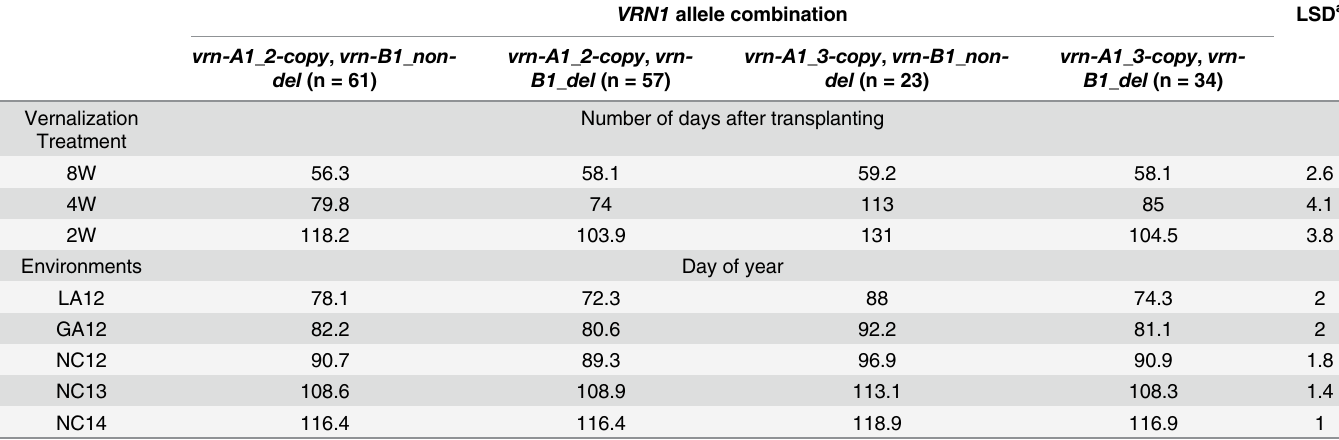
Table 3. Effect of VRN1 allele combinations on heading date in the greenhouse and field conditions.